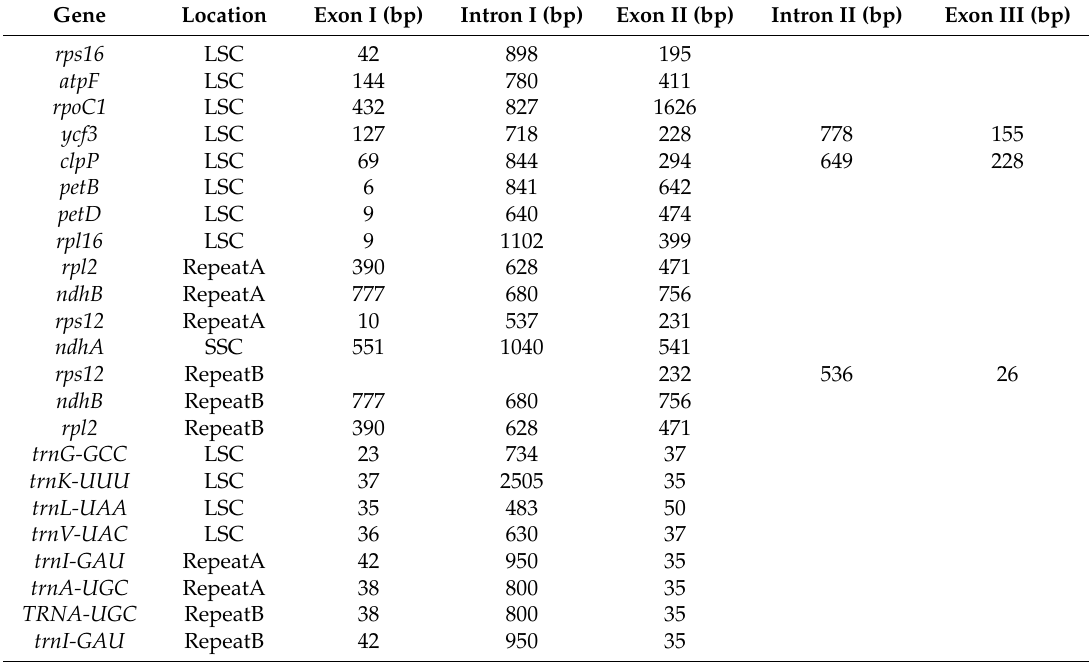
Table 4. The lengths of exons and introns in genes with introns in the Q. acutissima chloroplast